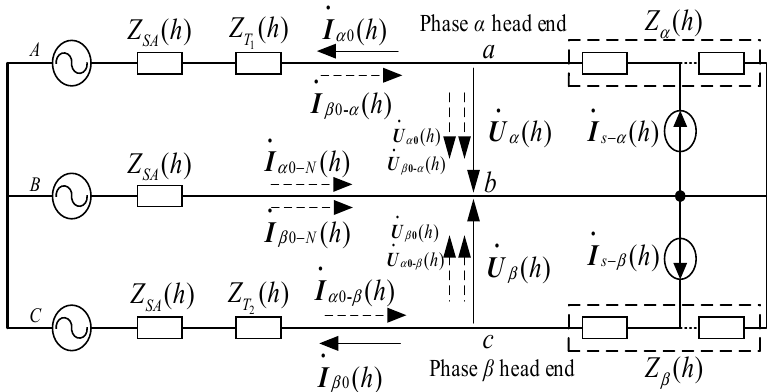
Figure 3. Harmonic transverse equivalent circuit of a V/v traction transformer.